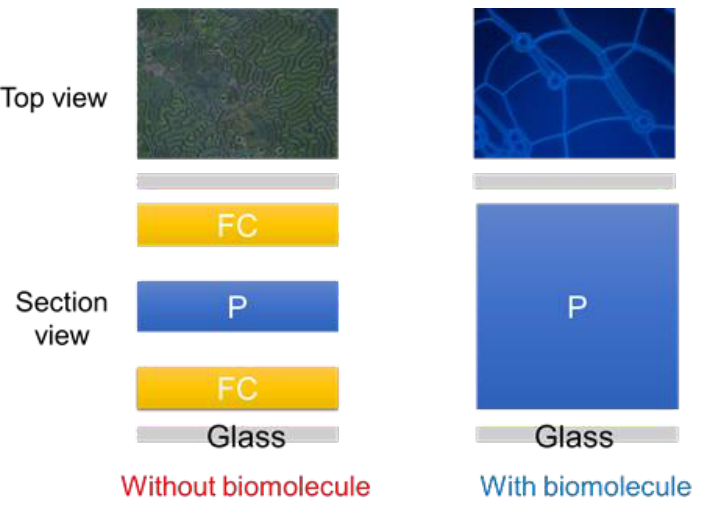
Figure 2. Optical mechanism and structure design of the cholesteric liquid crystal (CLC) biosensor both with and without the presence of biomolecules.